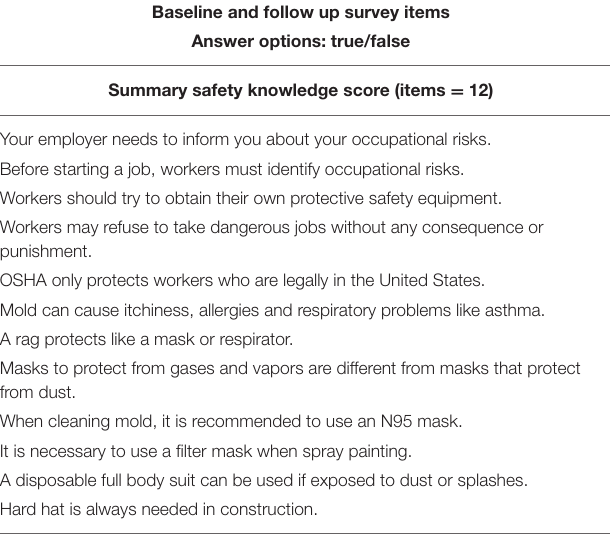
TABLE 1 | Preventive occupational knowledge associated with video intervention. Baseline and follow up survey